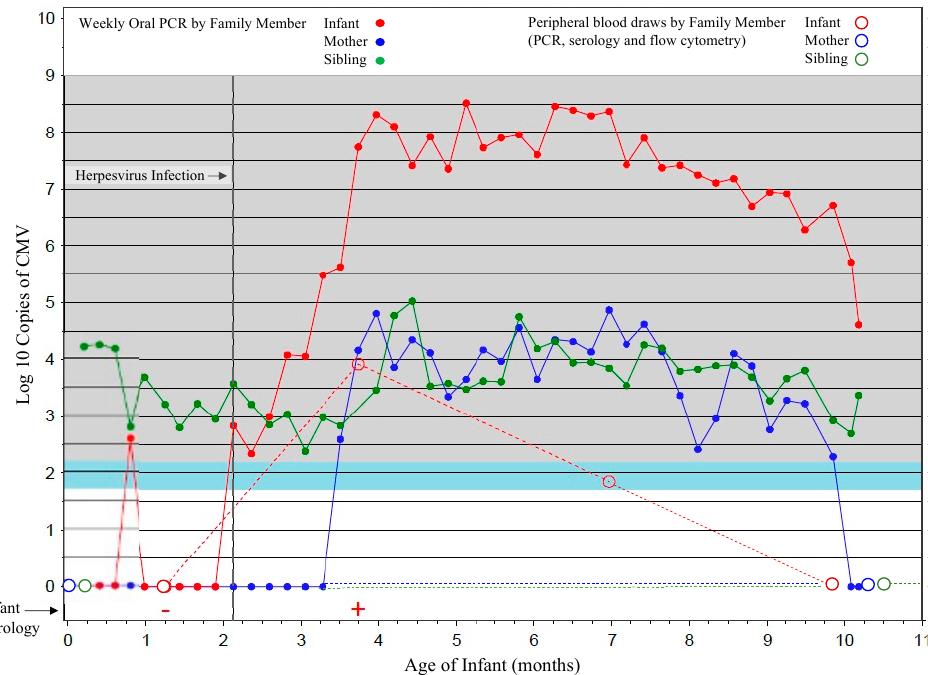
Figure 1. Sample scheme for cohort participants. A representative household is shown in which results for oral swabs (filled circles) collected weekly for viral PCR, and blood samples (open circles) collected at 6 weeks and then every 4 months thereafter for infants and at the time of delivery, and 1 year later for mothers and siblings, for viral PCR, serology, and flow cytometric analyses, are shown. Sampling of the infant is shown in red, mother in blue and sibling green.